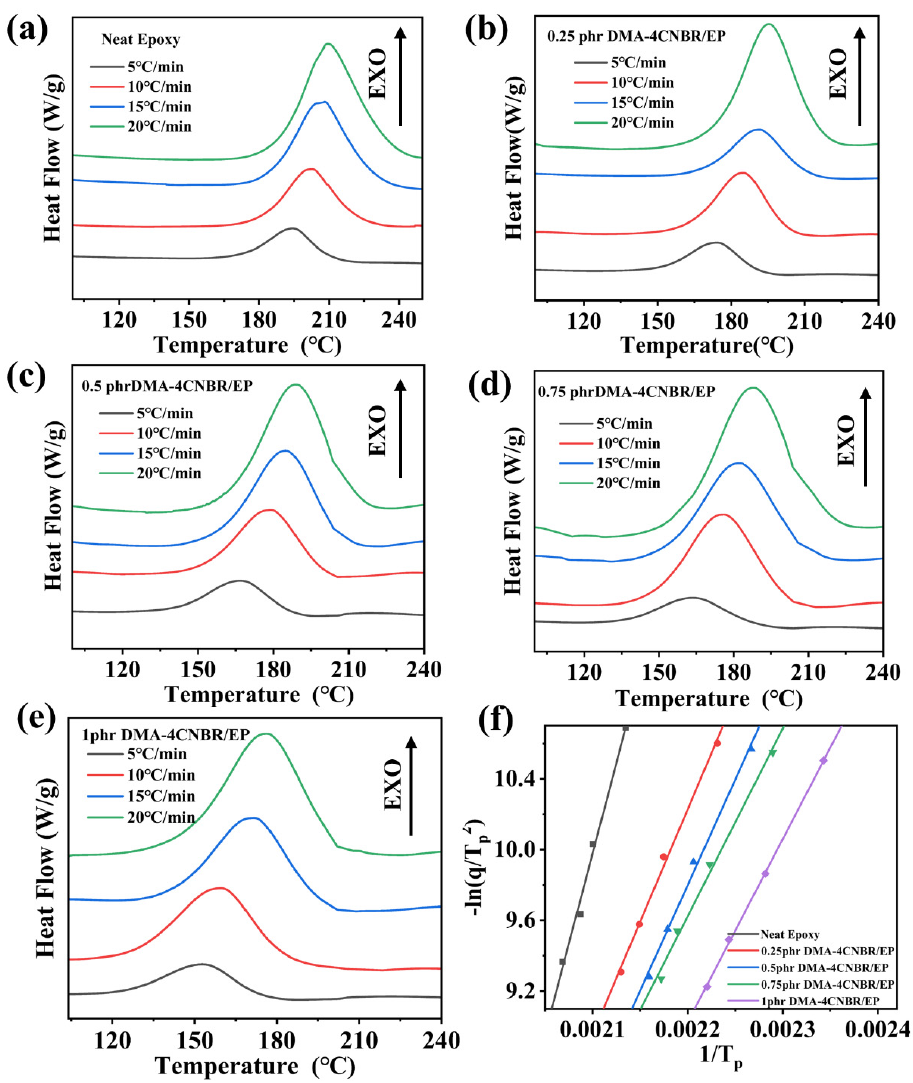
Figure 2. ( a , b ) DSC curves for different coatings at 10 °C/min ( c ) Gelling time of different propor- tions of DMA-4CNBR-modified epoxy coating.